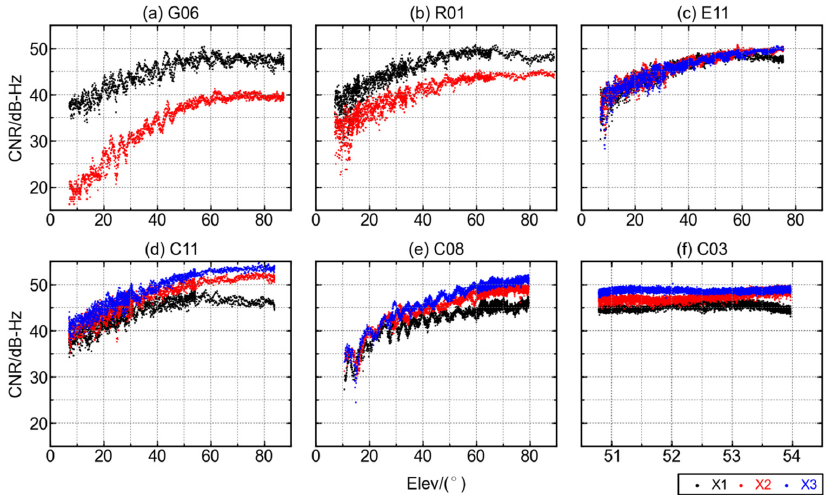
Figure 2. The relationship between CNRs and satellite elevations for GPS, GLONASS, Galileo, and BDS satellites at GNSS station F713. ( a ) G06; ( b ) R01; ( c ) E11; ( d ) C11; ( e ) C08; ( f ) C03. Three frequencies are denoted as X1, X2, and X3 with the colors black, red and blue.